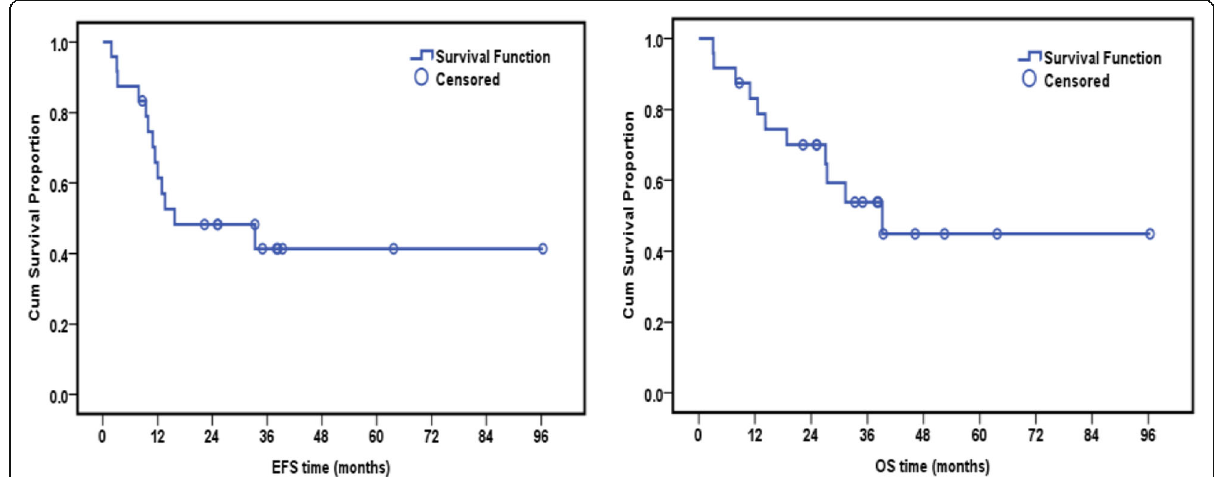
Fig. 5 3-year event-free and overall survival of study